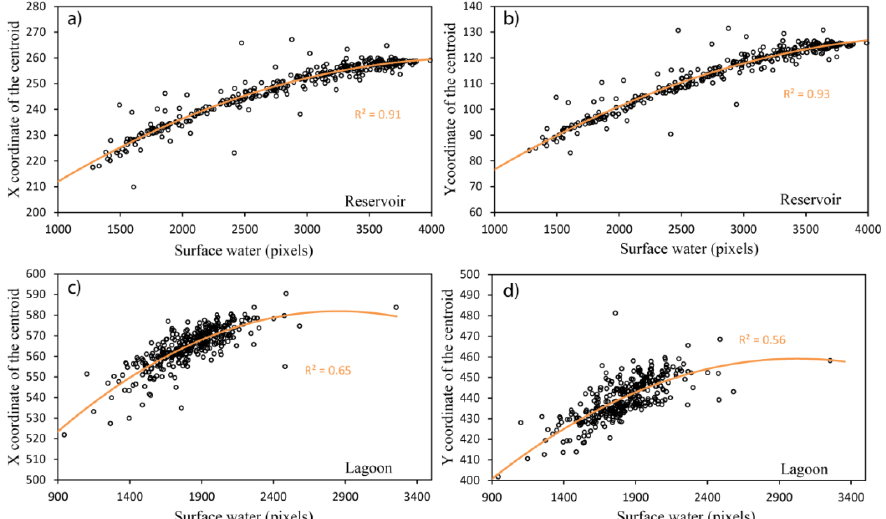
Figure 7. Relationship between the number of pixels covered by water and the centroid of the surface water: ( a ) for the X coordinate within the reservoir; ( b ) for the Y coordinate within the reservoir; ( c ) for the X coordinate within the lagoon areas; ( d ) for the Y coordinate within the lagoon areas.